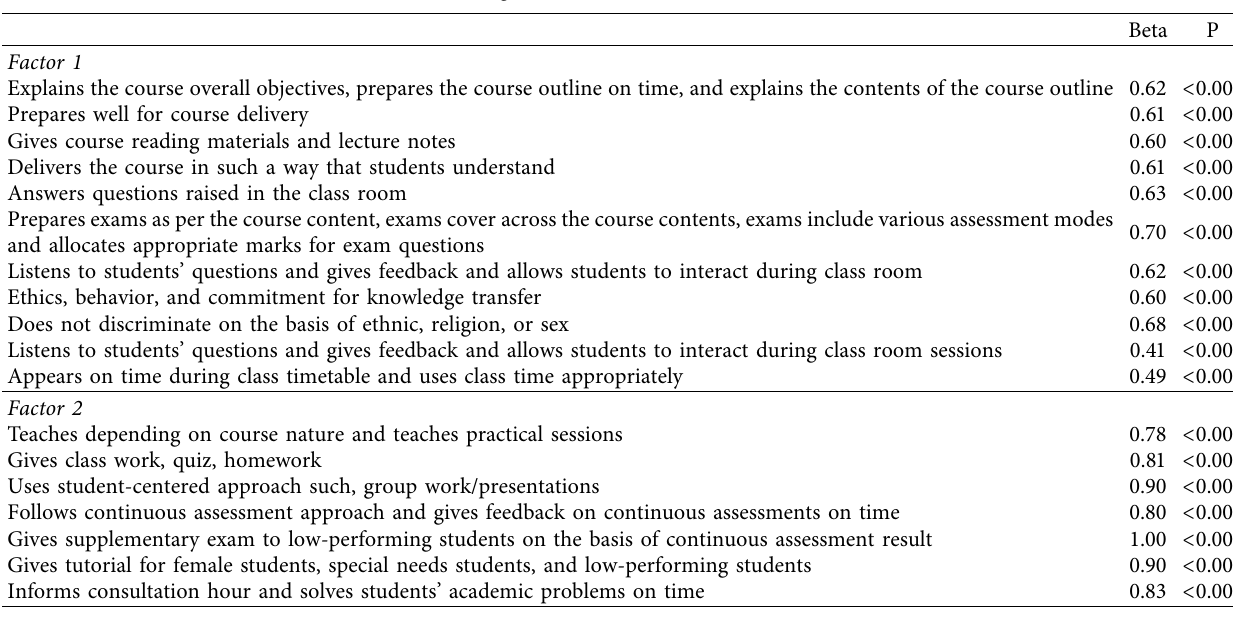
Table 5: Factor Loadings of the indicator items for the two-factor